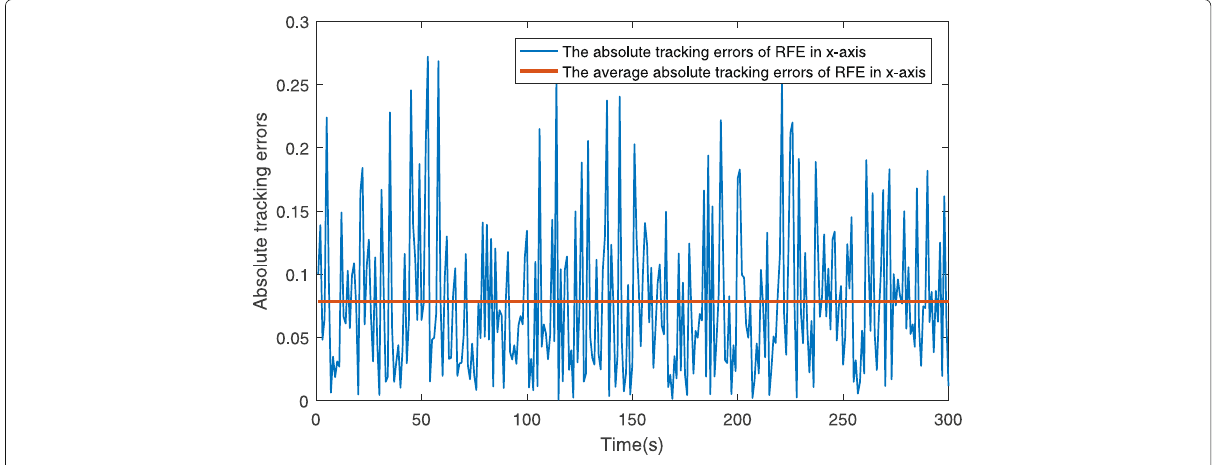
Fig. 7 The absolute tracking errors of RFE in x -axis with a i = 10